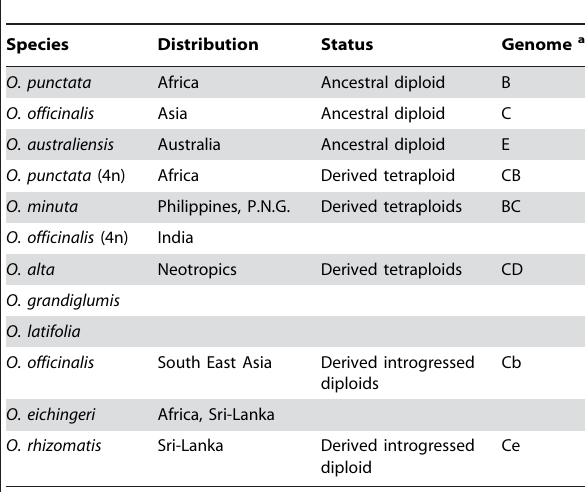
Table 2. The ‘ O. officinalis complex’, with a classification of species as ancestral and derived (post-domestication), and the corresponding genomes [see